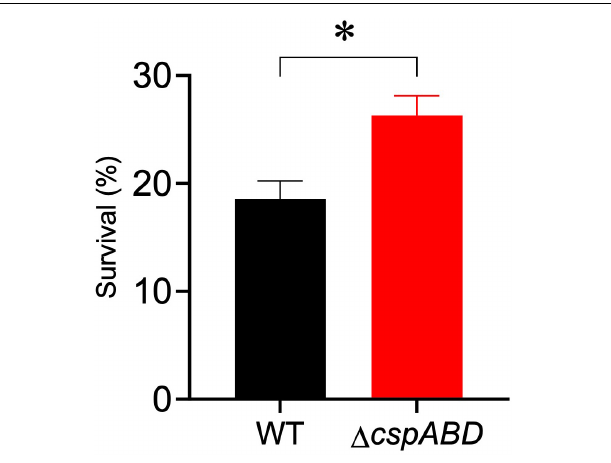
FIGURE 2 | Nisin stress survival comparison between L. monocytogenes EGDe wild-type (WT) and (cid:49) cspABD strains. Stationary-phase cultures were subjected to 7.5 ppm nisin stress in BHI at 37 ◦ C for 60 min. The survival for each strain expressed as a percentage was measured as the number of colony-forming units determined after nisin stress exposure normalized to the number of unstressed cells present at the beginning of stress exposure. Results showing the mean and SEM of six replicates representing three independent biological experiments are presented. ∗ P < 0.05, significant differences between the WT and (cid:49) cspABD strains identified using the t -test for comparison of independent